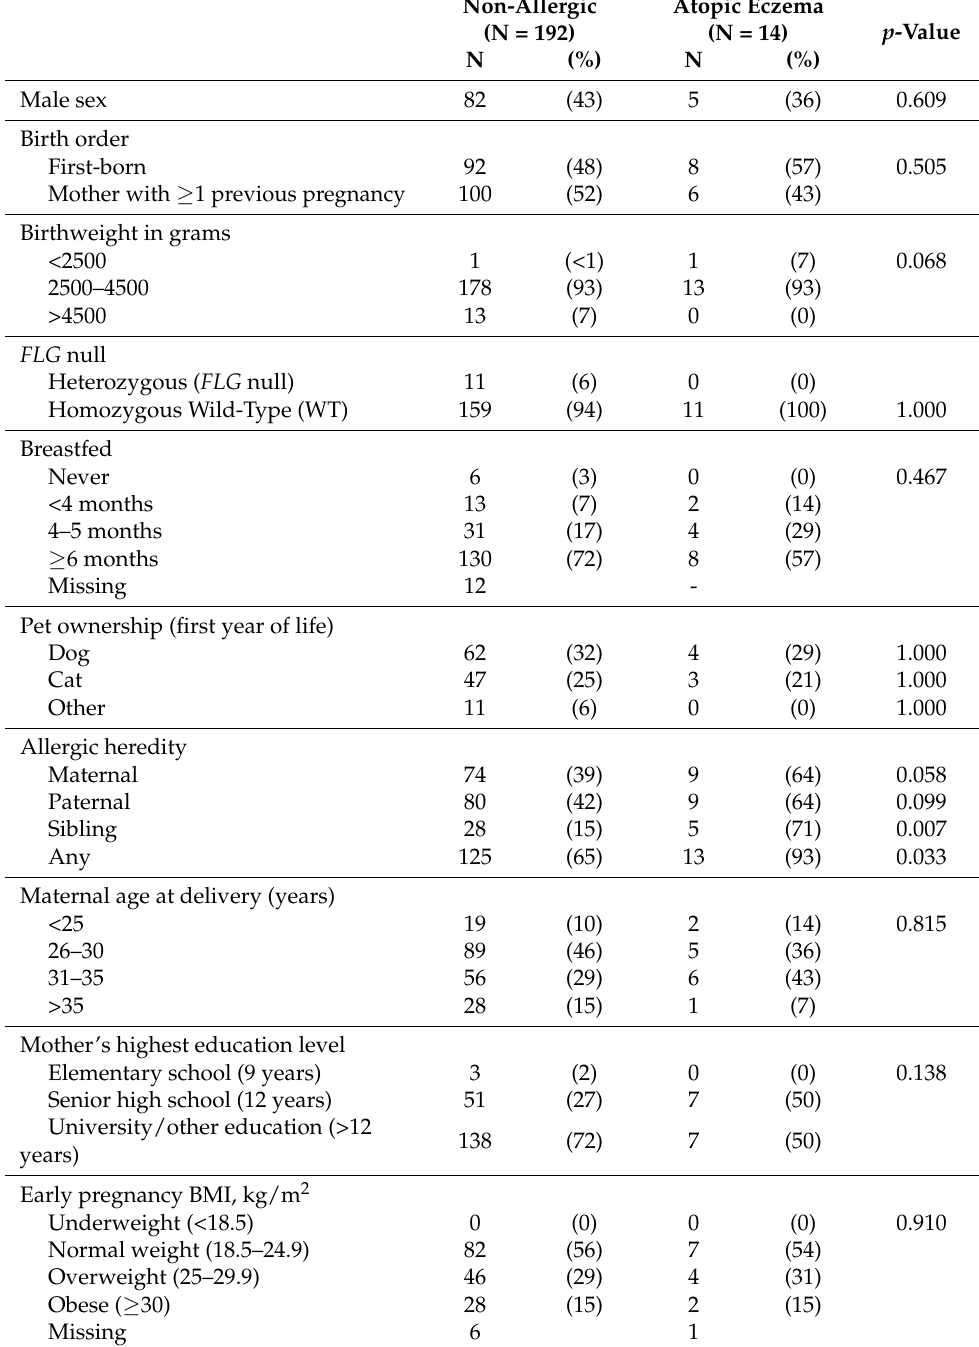
Table 1 lists the characteristics of the study participants, showing the differences between the allergic and non-allergic children. The vast majority of the infants were born by vaginal delivery and most were breastfed for at least 6 months. Children with eczema were more likely to have an allergic family member ( p = 0.033). More specifically, allergy in a sibling was highly predictive of eczema development during the first year of life ( p = 0.007). FLG loss of function mutation was not associated with the prevalence of atopic eczema. No other significant differences were found between the allergic and non-allergic children (Table 1). Table 1. Characteristics of infants with atopic eczema and non-allergic